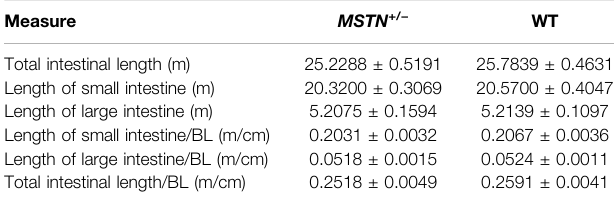
TABLE 1 | The intestinal length of 8-month-old MSTN +/ − and WT pigs.